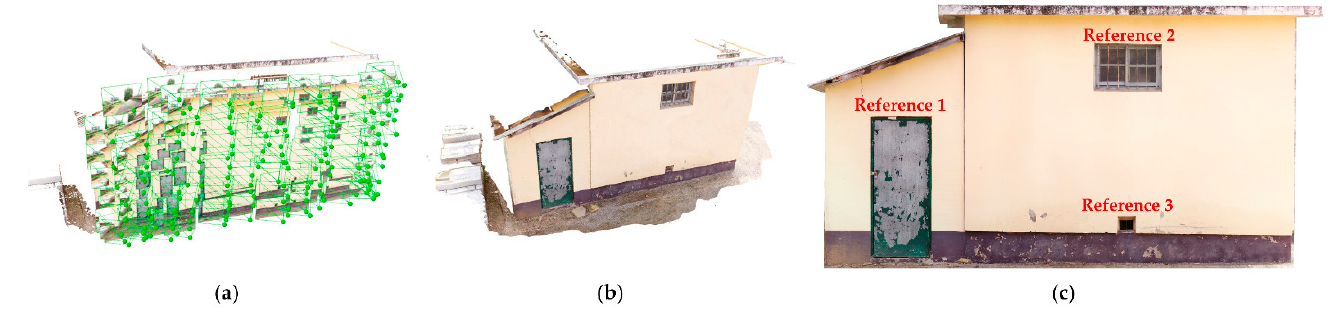
Figure 5. Process of orthoimage generation. ( a ) Initial processing; ( b ) Tie point matching and point clouding; ( c ) Orthoimage. Table 1. Size of the reference objects through analysis of 3D model.